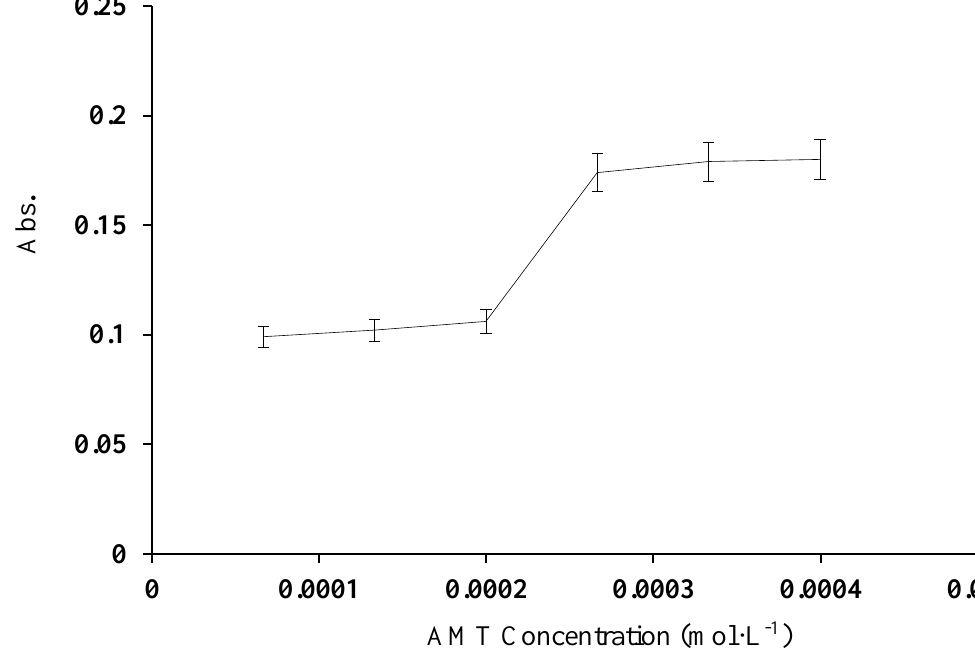
Figure 10. The relationship between the concentration of AMT reagent and the absorbance of [Cu( L )(NO 3 )(H 2 O) 2 ] • H 2 O at 434 nm. Cu(II) concentration = 2 µ g mL − 1 .